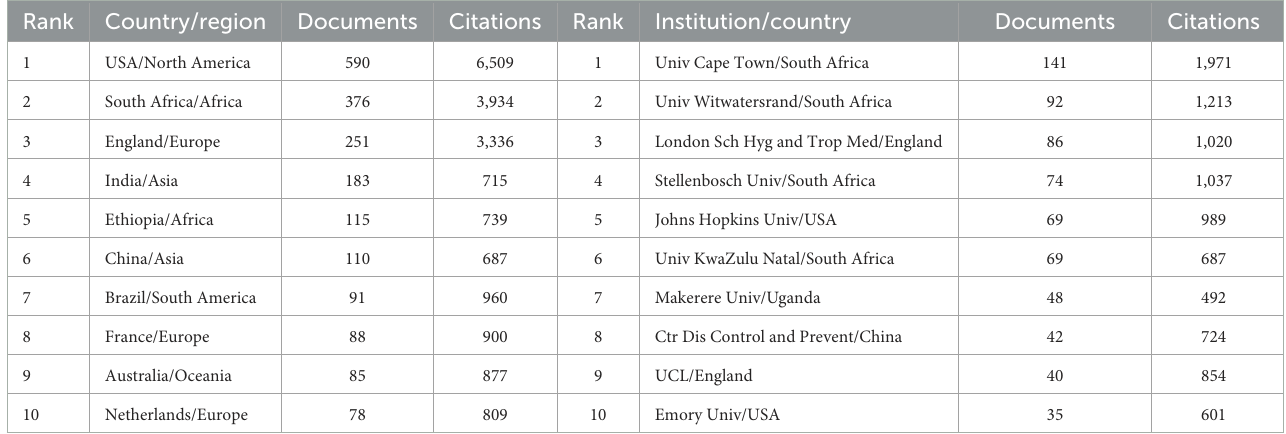
TABLE 1 The top 10 countries and institutes that contributed to publications about HIV-MTB co-infection. Rank Country/region Documents Citations Rank Institution/country Documents